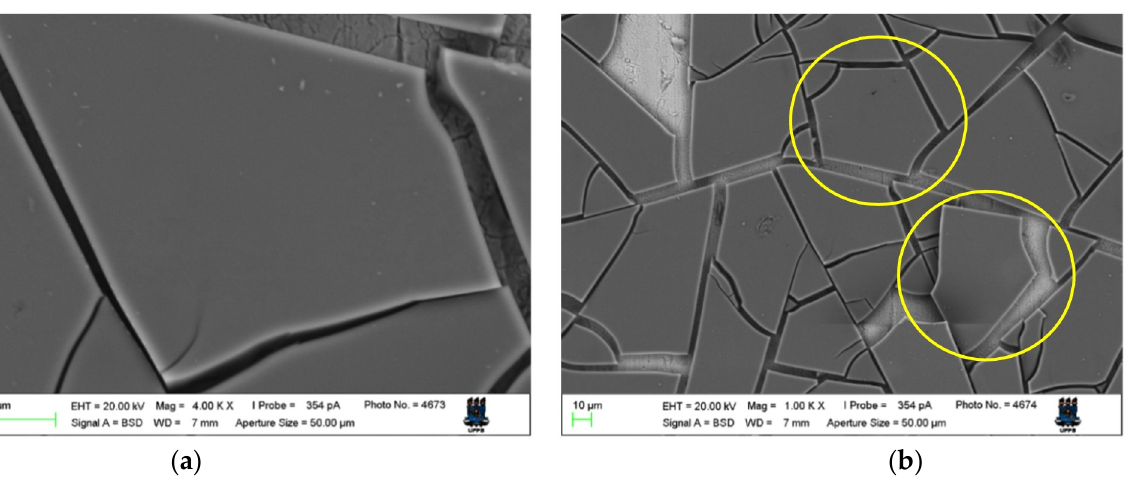
( b ) Figure 10. Scanning electron microscopy for samples with AT (acid treatment) and 1 min deposition time. Magnifications: ( a ) 4000×; ( b ) 1000×. Surface morphology analysis by SEM for samples that have been electropolished (EP) is illustrated in Figure 11.